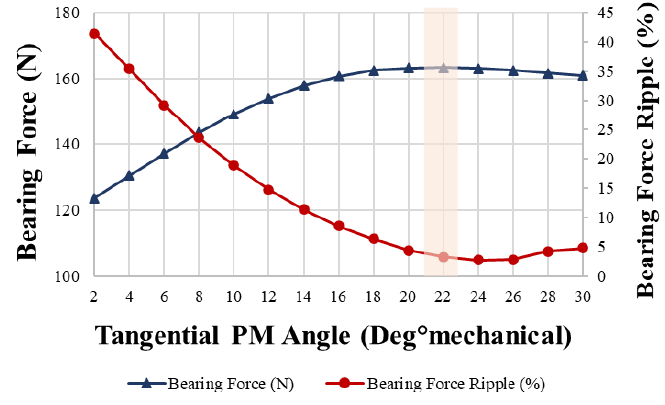
Figure 13. Bearing force and ripple according to tangential PM angle.